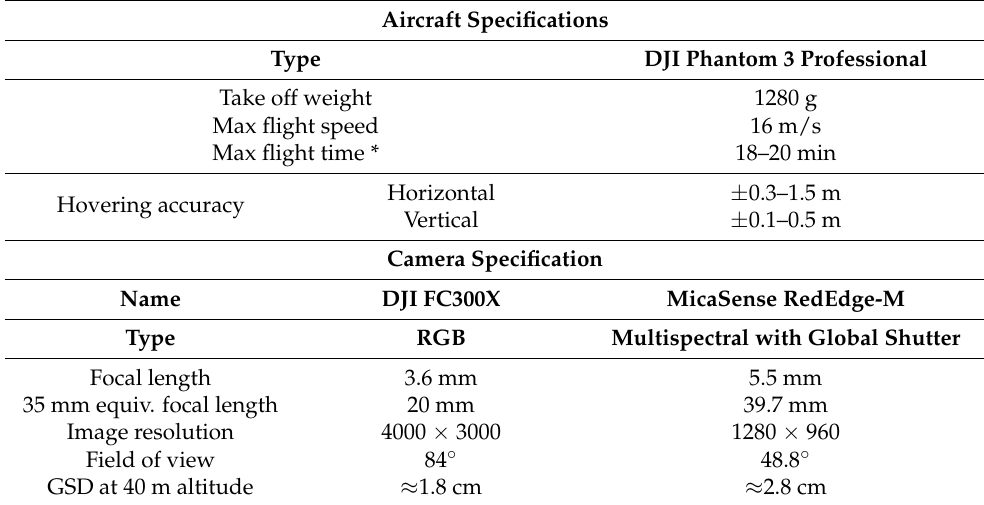
Table 1. Aircraft and camera